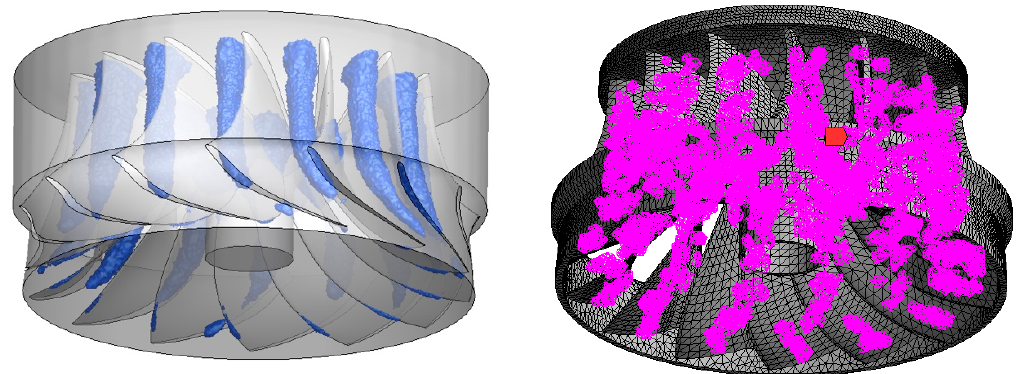
Figure 6. Mapping of cavity shapes into FEM ( right ) from CDF simulation results ( left ) at deep part load condition.